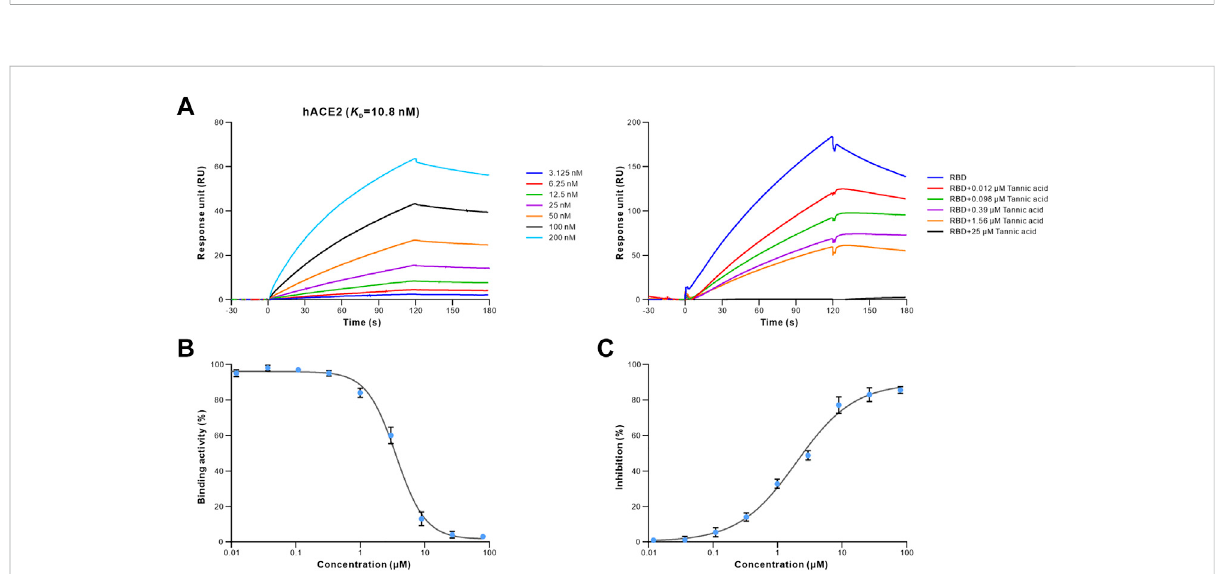
FIGURE 4 Antiviral activity of tannic acid against SARS-CoV-2. The binding activity of S-RBD to hACE2 in the presence of increasing concentrations of tannicacid. (A) SPRanalysiswasperformedtoassesstheS-RBDbindingtohACE2(left).40nMofS-RBDwasusedinthecompetitiveSPRexperiment at gradient concentrations ranging from 25 μ M to 0.012 μ M (right). The binding curves were analyzed using a kinetic analysis supplied with Biacore Evaluation Software. Data are presented as RU over time (s). The K D were calculated using a 1:1 binding model. (B) Competitive ELISA was performed to analyze the inhibition activity of tannic acid on S-RBD binding to hACE2. The dose-response curve for IC 50 value was determined by nonlinear regression. (C) Antiviral activity of tannic acid against pseudotyped SARS-CoV-2 in HEK293T-hACE2 cells. Pseudotyped SARS-CoV-2 was used to infect the HEK293T-hACE2 cells pre-incubated with tannic acid at gradient concentration ranging from 80 μ M to 0.004 μ M. The luciferase activities in cell lysates were determined at 48 h post transduction to calculate infection (%) relative to non-treated control. Data were shown as mean ± SEM of a representative